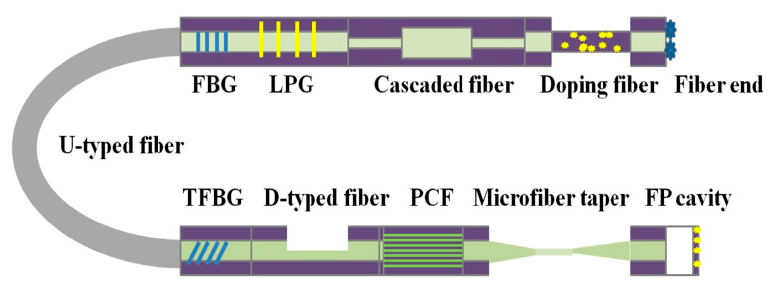
Figure 2. Common fiber structures for exploring LSPR fiber sensors.